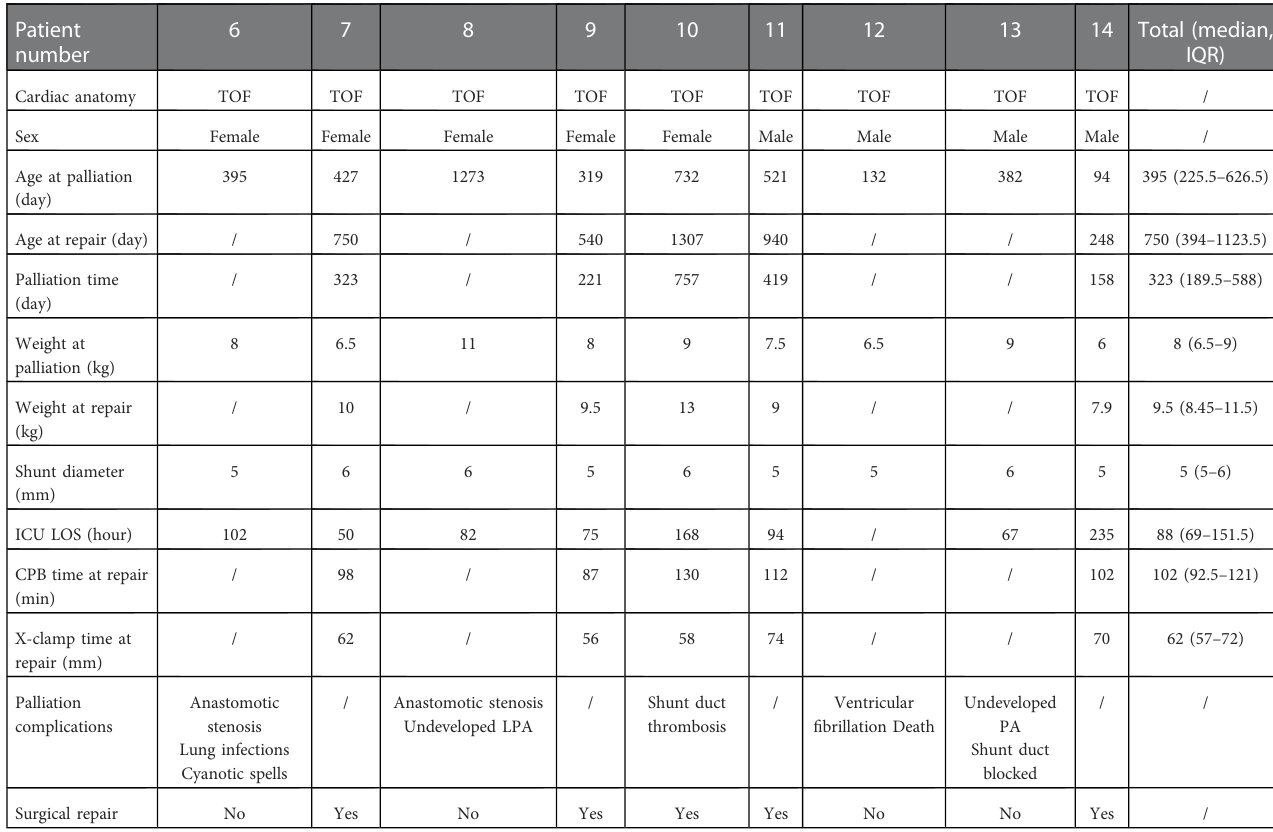
Table 3 demonstrates the pulmonary arteries diameter data obtained from cardiovascular CTA and the blood oxygen saturation at palliation period and pre- fi nal repair. All 5 patients underwent transpulmonary valve ROVT stent, with the distal end of the stent placed in the right pulmonary artery or pulmonary artery trunk. Nine patients underwent the surgery that connect the right subclavian artery and the right pulmonary artery by shunt tube. Noteworthy, all patients demonstrated a rapidly increase in blood oxygen saturation after RVOT stent implantation compared with preoperative. Oxygen saturations increased from median of blood oxygen saturation during palliative periods may be due to in-stent obstruction or the increased hypertrophy of right ventricular out fl ow tract, or it is related to the relative hypoxia due to the increase in the infant ’ s oxygen demands with the development of the body. In the mBTS group, Oxygen